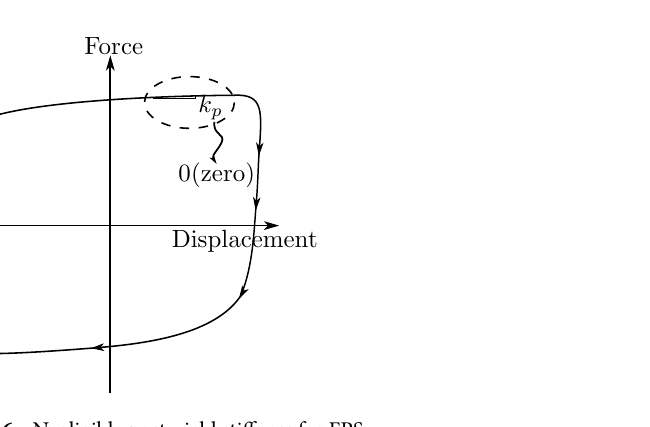
Figure 6. Negligible post-yield stiffness for